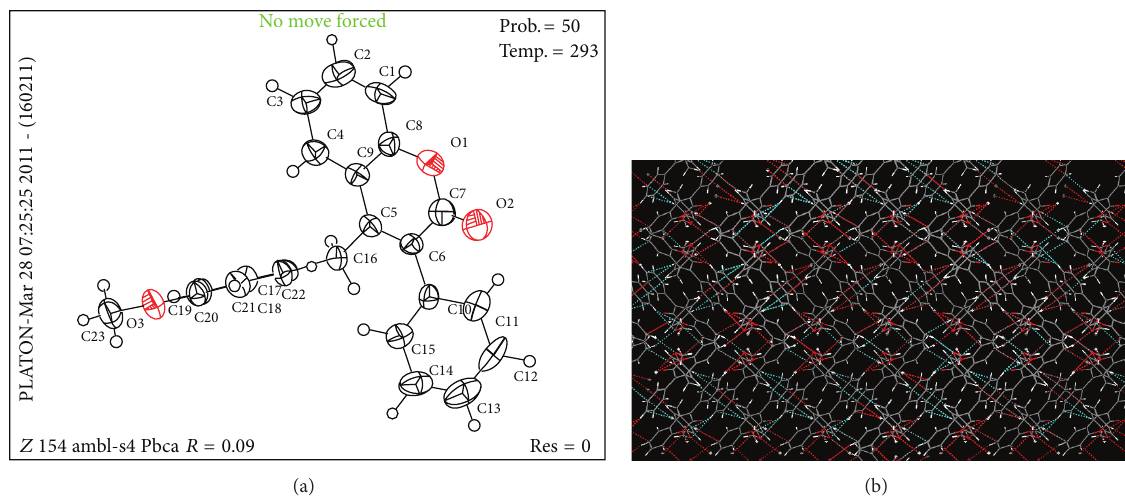
Figure 3: (a) ORTEP/PLATON structure of ( vi - e ). (b) Packing structure of ( vi - e ) showing Z-like packing.